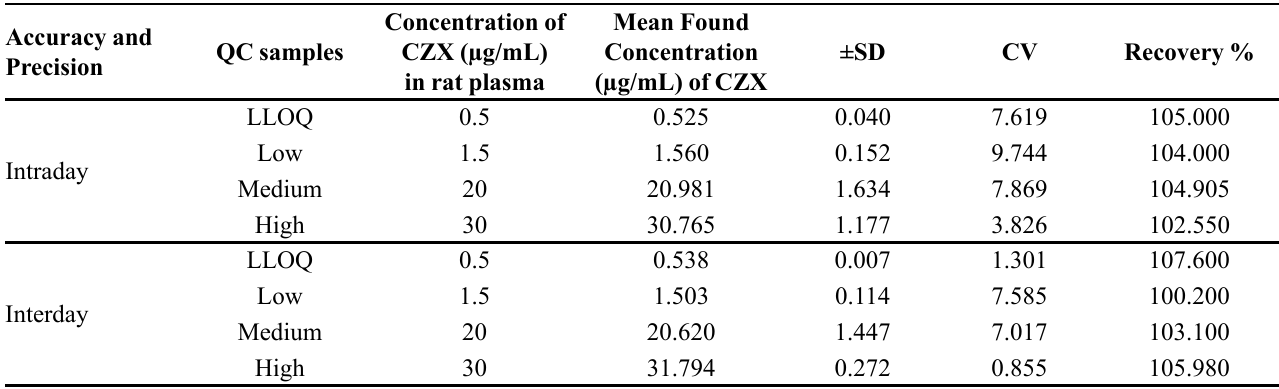
TABLE III - The results of short, long and freeze and thaw Stability of paracetamol in rat plasma